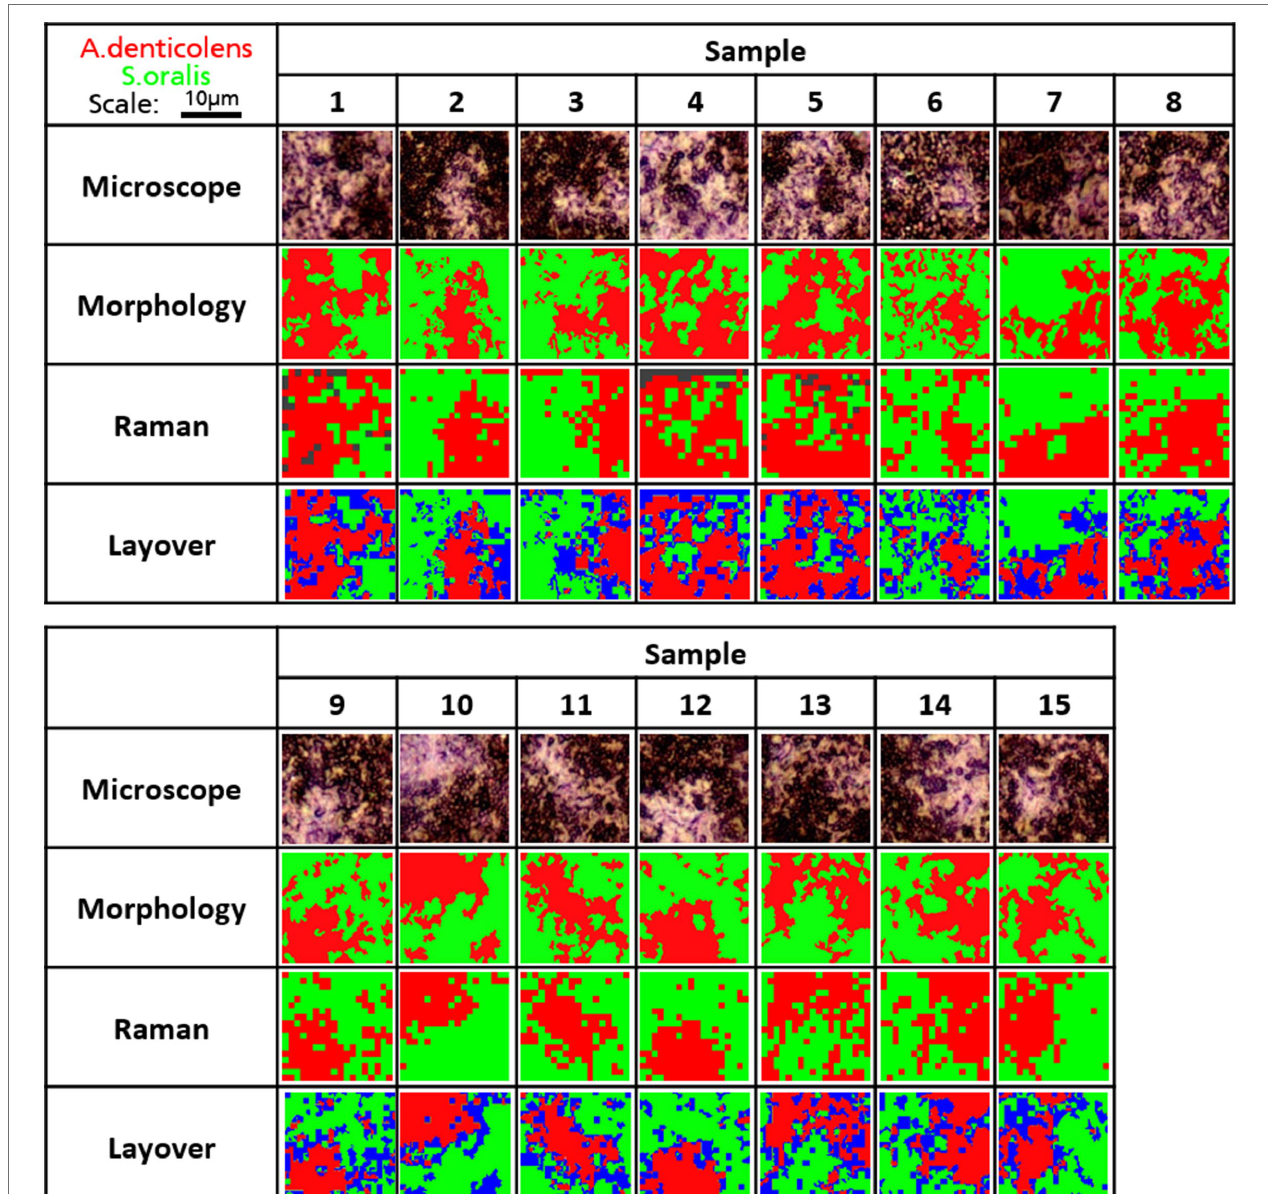
FIGURE 6 | Distribution of A. denticolens and S. oralis in 15 multi-species biofilms. Morphological and Raman analysis was performed using the identical random area in a sample. Morphological analysis was done using ImageJ with the plugin MorphoLibJ. Raman analysis as performed using PCA-based cluster analysis with WiRE 5.4. Gray areas show unidentified areas. Morphology and Raman images were laid over to show areas that were not classified as the same species and were labeled